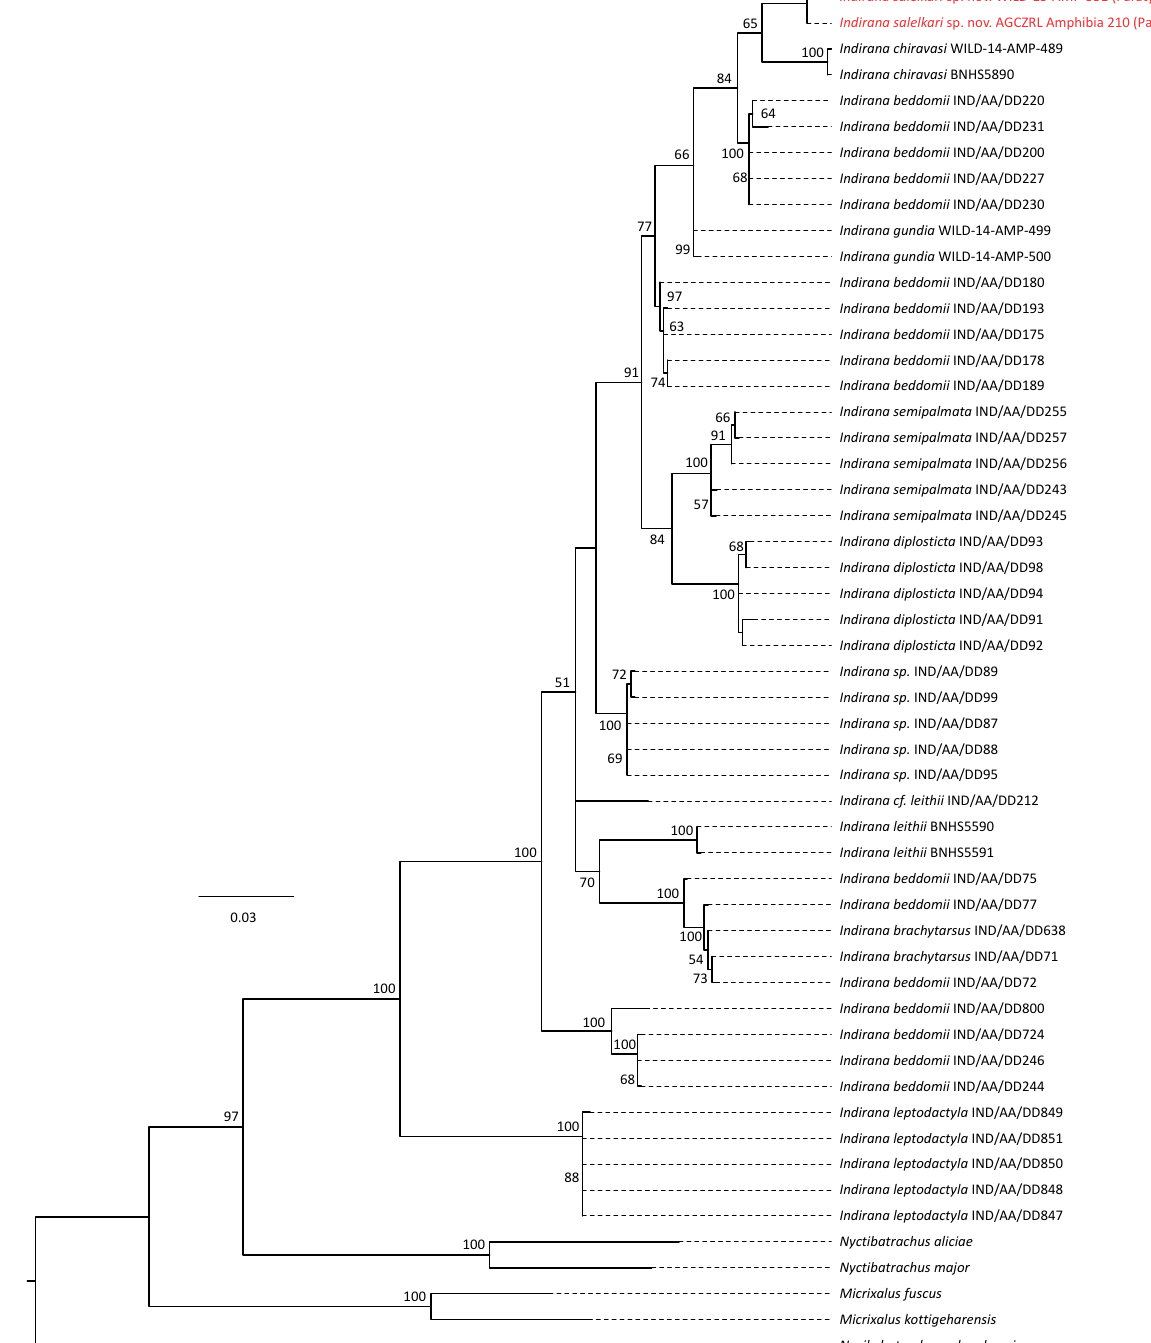
45, Image 7) stages (McDiarmid & Altig 1999)